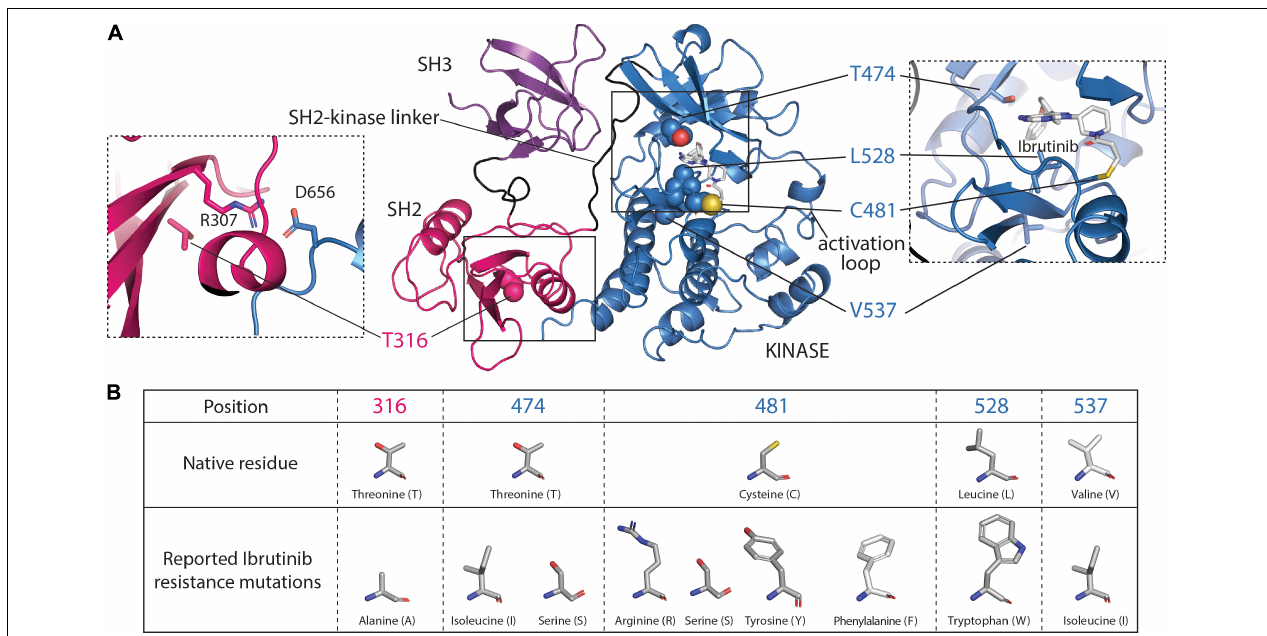
FIGURE 2 | Ibrutinib resistance mutations mapped onto the SH3–SH2-kinase fragment of BTK. (A) The monomeric model of the SH3–SH2-kinase module of BTK is shown (Wang et al., 2015) with the SH3, SH2, and kinase domains colored purple, pink, and blue, respectively. The BTK kinase domain structure bound to Ibrutinib [Protein Data Bank (PDB) code: 5P9J] was used to place Ibrutinib in the SH3–SH2-kinase model. Ibrutinib resistance mutations that have been described at T316, T474, C481, L528, and V537 are shown. The left dashed box highlights the R307/D656 salt bridge in proximity to T316. The right dashed box highlights the Ibrutinib resistance mutations surrounding the active site. The boxed image here was taken from the Ibrutinib-bound kinase domain structure (PDB:5P9J). (B) The table presents structures of native amino acid residues and the corresponding Ibrutinib resistance mutations reported to